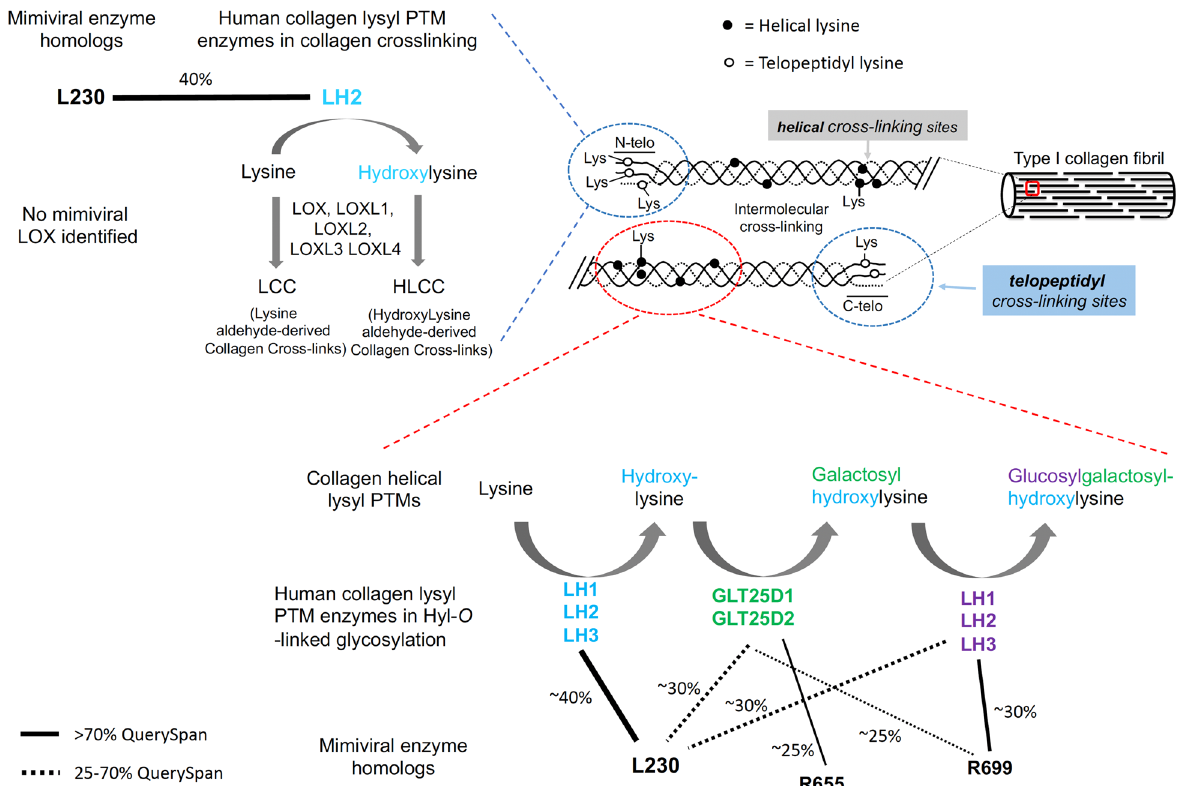
Figure 2. Schematics showing collagen lysyl PTMs pathway and its homology to mimiviruses. Sequence alignments suggested that mimiviral L230, R699 and R655 are homologous to human collagen lysyl modifying enzymes involved in collagen crosslinking and Hyl- O -linked glycosylation. A newly identified mimiviral putative collagen glycosyltransferase R699 shares higher amino acid sequence identity (~ 30%) with human collagen GGTs than hydroxylysyl galactosyltransferases (GLT25D1 and GLT25D2). Homology was indicated with black lines (solid black lines if percentage of QuerySpan was higher than 70%, and dashed black lines if percentage of QuerySpan fell between 25% and 70%) and the percentage of amino acid sequence identity was